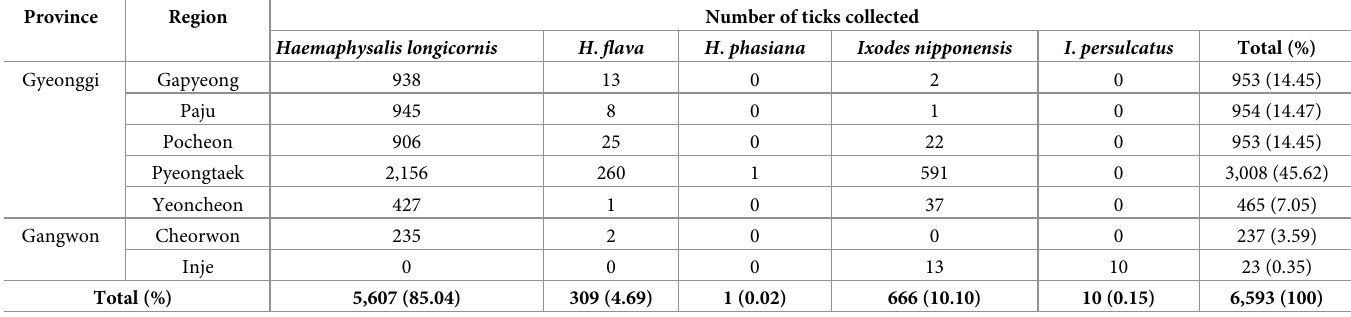
Table 1. Geographical distribution of tick species collected from Gyeonggi and Gangwon Provinces, Republic of Korea, during 2019–2020. Province Region Number of ticks